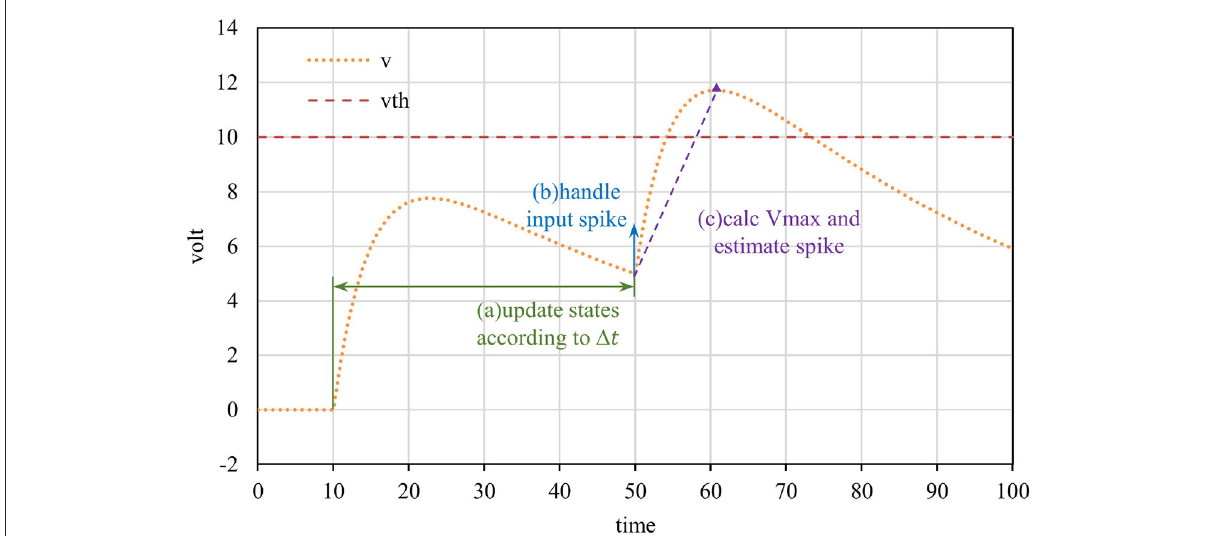
FIGURE2 Event-driven neuron updated diagram. The neuron is updated when a spike is received, which consists of three sub-steps: updating states, processing the input spike, and predicting the potential